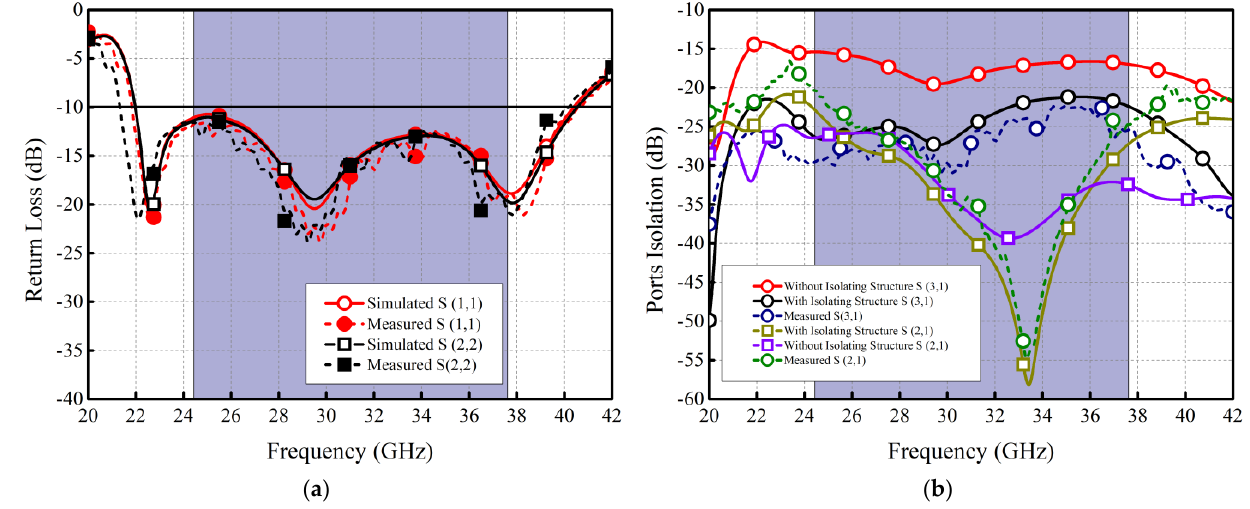
Figure 8. Simulated and Measured S-Parameters. ( a ) Return loss ( b ) Ports Isolation.